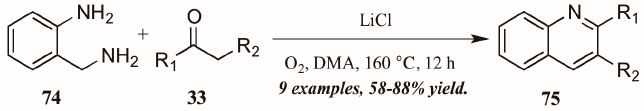
Figure 33. Oxidative cyclization of aryl diamines with carbonyl compounds.